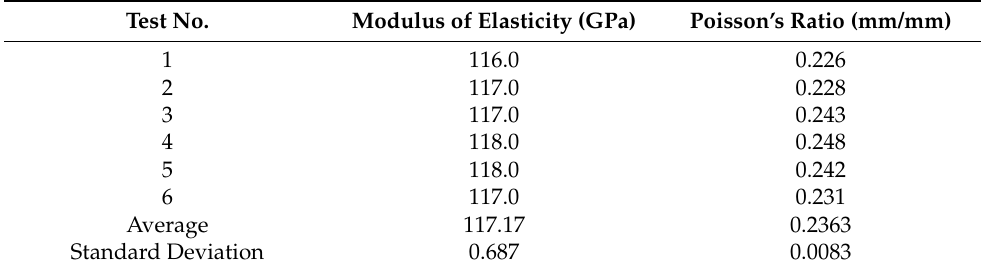
Table 5. Equivalent properties of Specimen Type I [13].